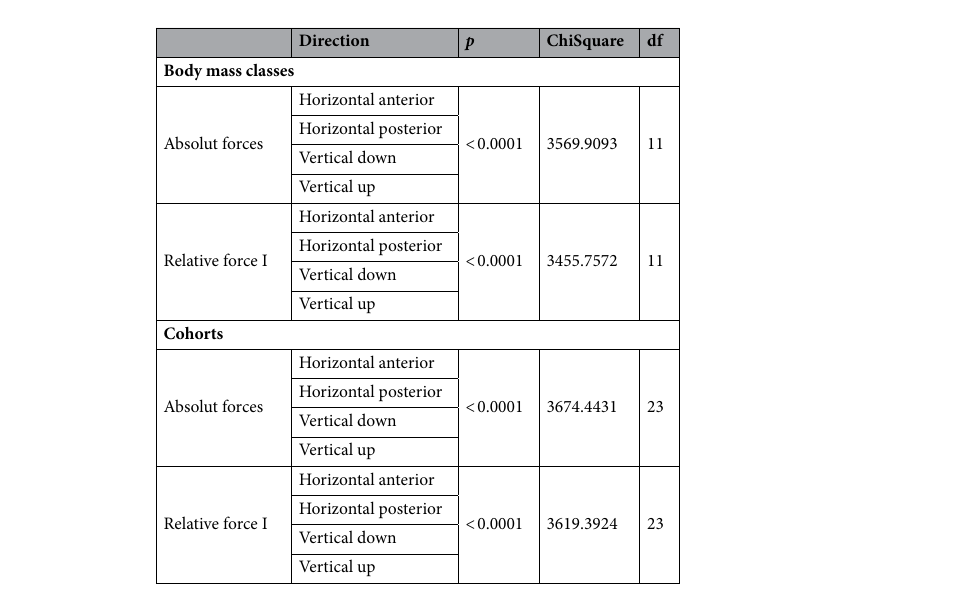
Table 2. For body mass classes and cohorts: results from Kruskal–Wallis test for absolute force and relative force I.